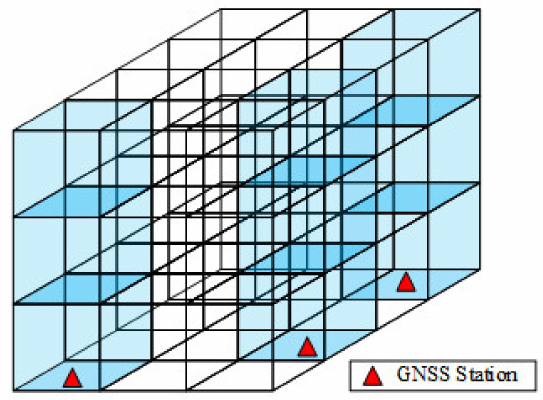
Figure 4. Precipitable WV (PWV) constraints imposed upon the tomographic